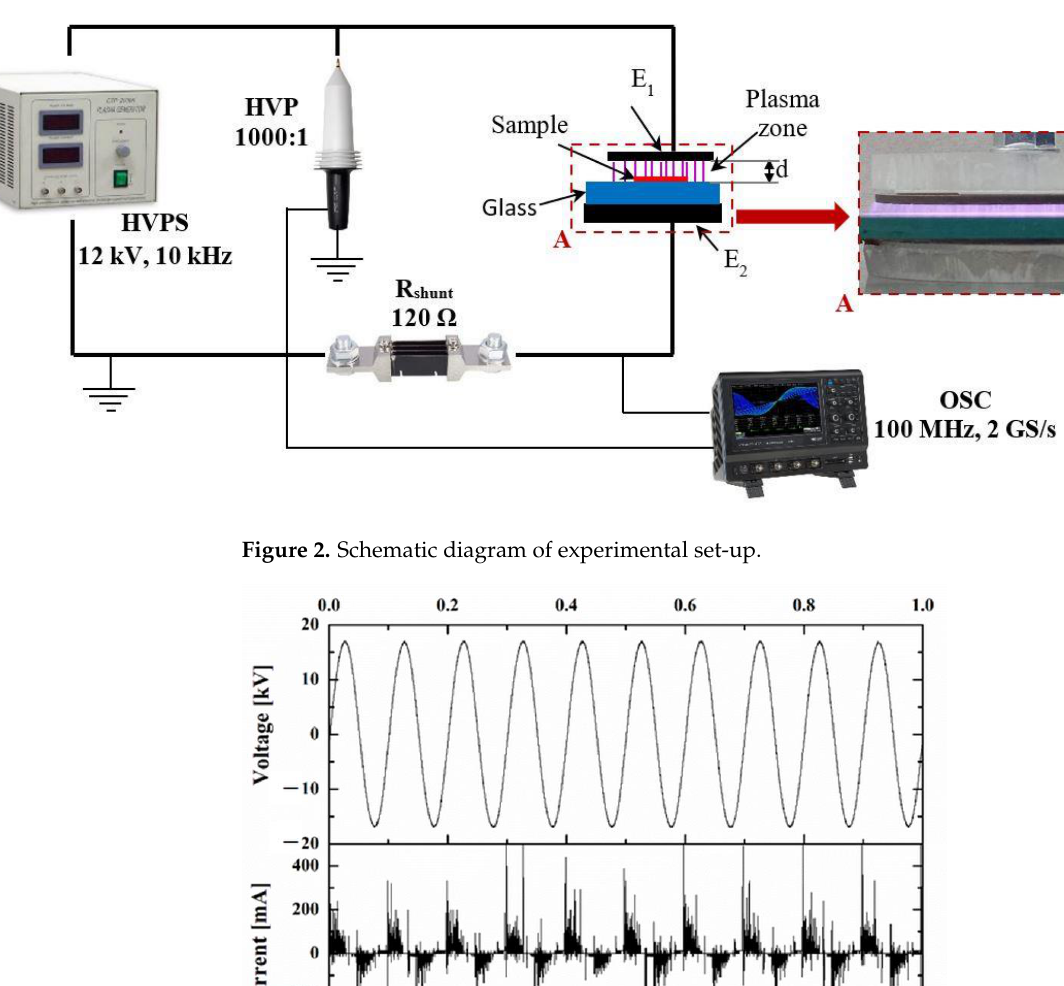
Figure 2. Schematic diagram of experimental set-up.